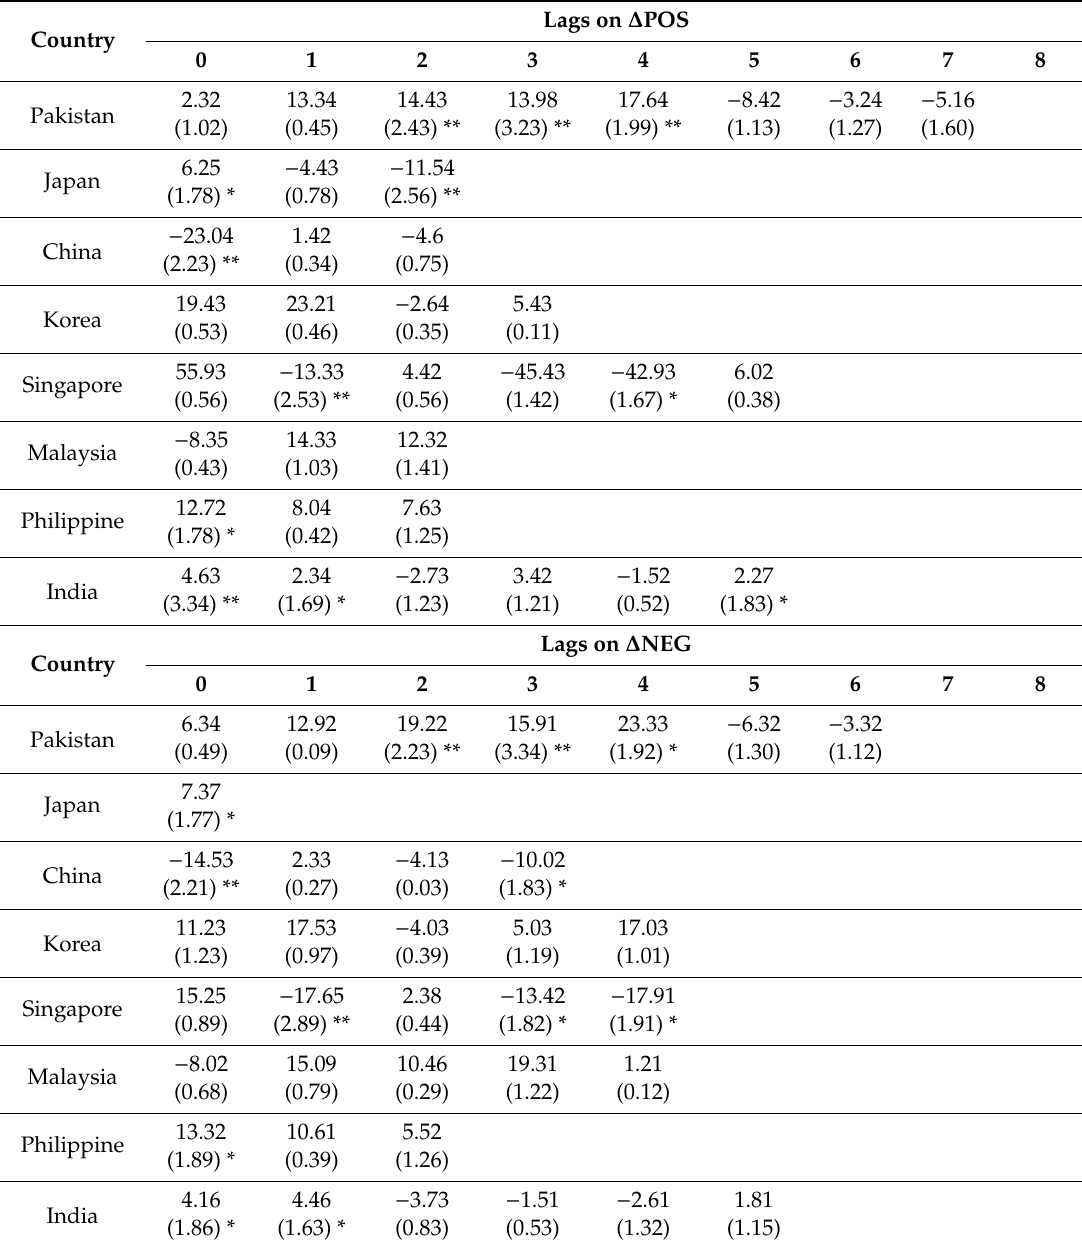
Table 5. Short-run Coe ffi cient Estimates Attached to ∆ POS and ∆ NEG in the Non-Linear Export Demand Model